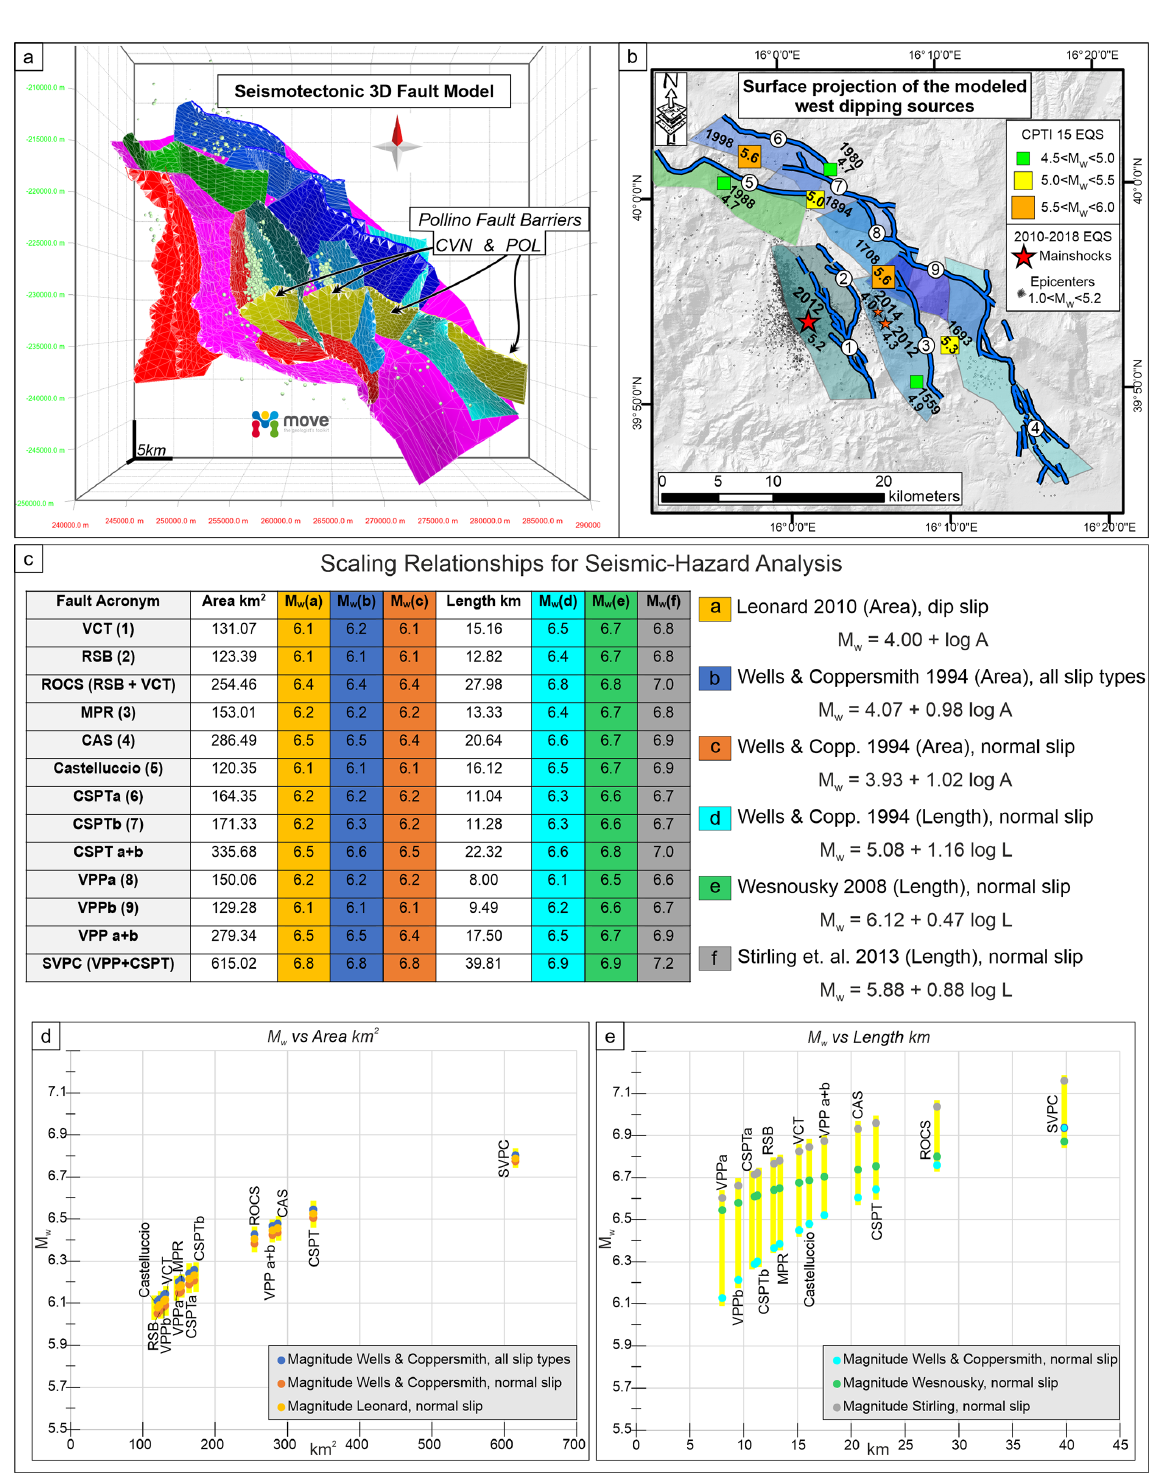
Figure 9. (a) Seismotectonic 3D fault model in map view. (b) Box representation of the W-dipping seismogenic faults belonging to the 3DFM with a detailed segmentation pattern. Fault traces are numbered according to the table of (c) . The associated historical earthquakes from CPTI15 v3.0 (4 . 5 <M w < 6 . 0; Rovida et al., 2020, 2021) and the epicentral distribution of the 2010–2018 seismic activity that occurred in the Pollino area (1 . 0 <M w < 5 . 2) are also reported. (c) Expected magnitude according to scaling laws (Wells and Coppersmith, 1994; Wesnousky, 2008; Leonard, 2010; Stirling et al., 2013) and calculated based on fault area (A) and length (L). (d, e) Comparison of magnitude values calculated for all the investigated active faults, using fault-area-based (d) and fault-length-based (e) scaling relationships.